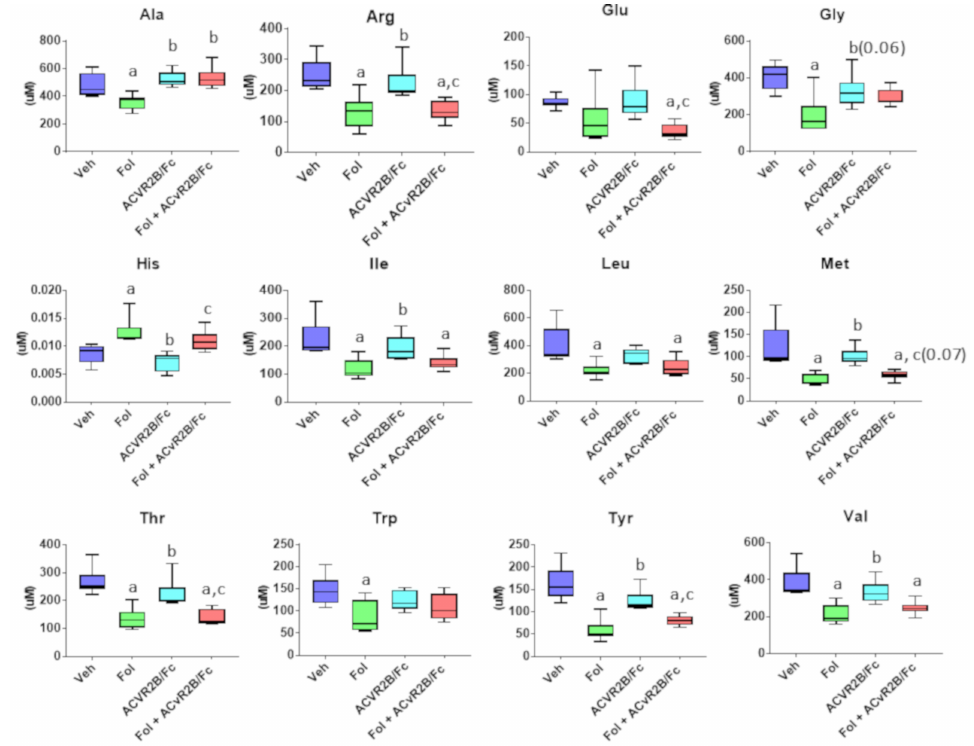
Figure4. Serumlevelsofaminoacidsshowingatleastonesignificantinter-groupdi ff erence. Significance di ff erences include p -values < 0.05 for a vs. Veh, b vs. Folfiri, c vs. ACVR2B /